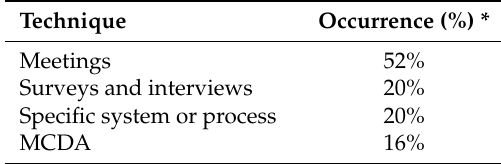
Table 9. Techniques for handling participatory planning problems.